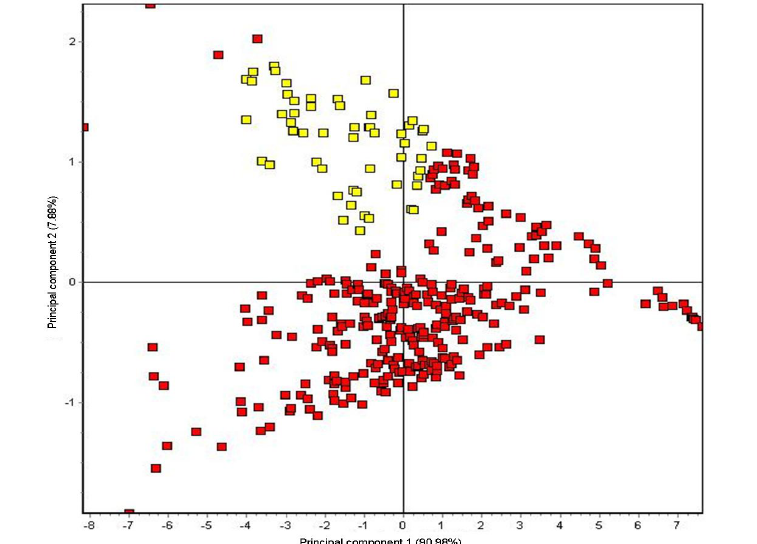
Figure 3. Aroma map plot showing discrimination of volatiles from healthy control wood blocks (yellow labels) and volatiles from artificially-inoculated decayed wood block (red labels) using principal component analysis (PCA) of mean changes (shifts) in quartz crystal oscillation frequency ( Δ f) in response to differences in VOC mixture composition in headspace volatiles from different sample